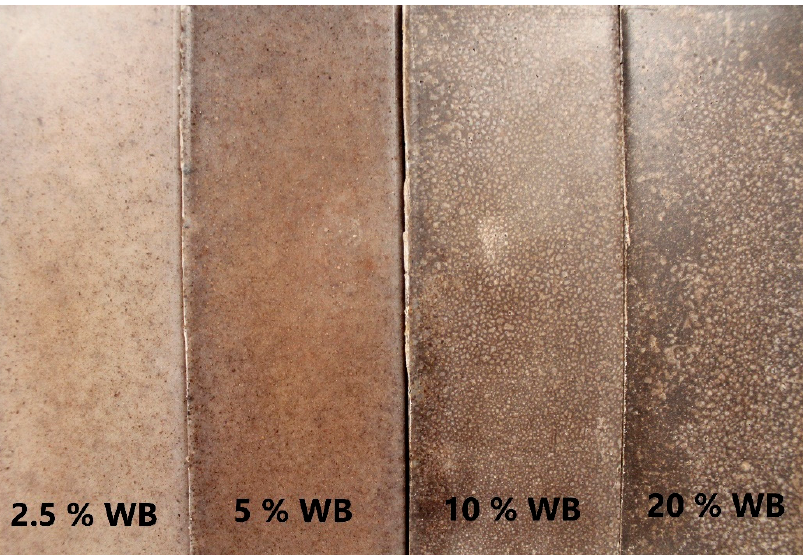
ff erent loadings of wheat